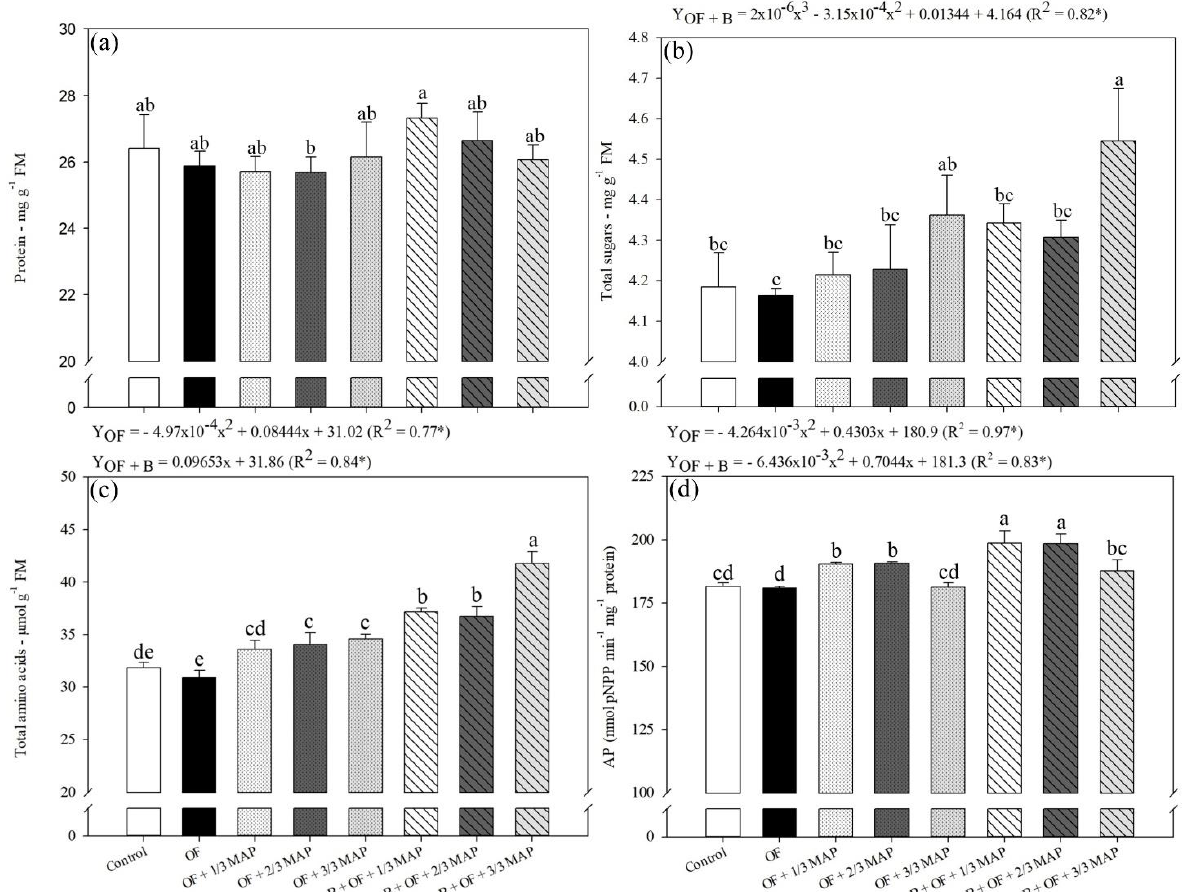
Figure 4. Protein content ( a ), total soluble sugars ( b ), total amino acids in the leaves ( c ), and leaf acid phosphatase (AP) activity ( d ) of sugarcane under the association of organomineral fertilizer (OF), B. velezensis (B), and doses of mono ammonium phosphate (MAP). Means followed by the same letter do not differ from each other by the Tukey test at 5% probability. The error bars express the standard deviation of the mean (n = 4). The regression equations and R 2 above the figures include the MAP doses associated with organomineral fertilizer (OF) and with organomineral fertilizer + B. velezensis (OF + B) at the 5% significance level